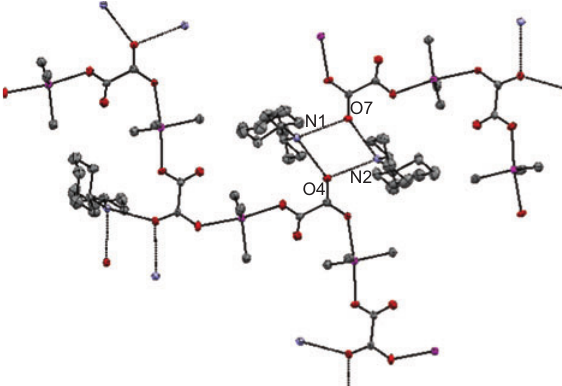
Figure 2 The lattice structure of 2 showing the pattern of hydrogen bonds. Geometric data: Selected bond distances: Sn(1)-C(2)2.112(3); Sn(1)-C(3)2.128(3); Sn(1)-C(1)2.130(3); Sn(1)O(1)2.215(2); Sn(1) O(8) # 12.295(2); Sn(2)-C(7)2.109(3); Sn(2)C(6)2.127(3); Sn(2) C(8)2.135(3); Sn(2)-O(5)2.238(2)Sn(2)-O(3)2.315. Selected bond angles: C(2)-Sn(1)-C(3) 116.63(13); C(2)-Sn(1)-C(1)133.50(13); C(3)-Sn(1)-C(1)109.27(13); C(2)-Sn(1)-O(1)92.43(11); C(3)-Sn(1)- O(1)99.88(11); C(1)-Sn(1)-O(1)86.67(10); C(2)-Sn(1)-O(8) # 1 86.48 (11); C(3)-Sn(1)-O(8) # 186.86(11); C(1)-Sn(1)-O(8) # 189.00(10); O(1)-Sn(1)-O(8) # 1172.90(8); C(7)-Sn(2)-C(6)132.45(13); C(7)-